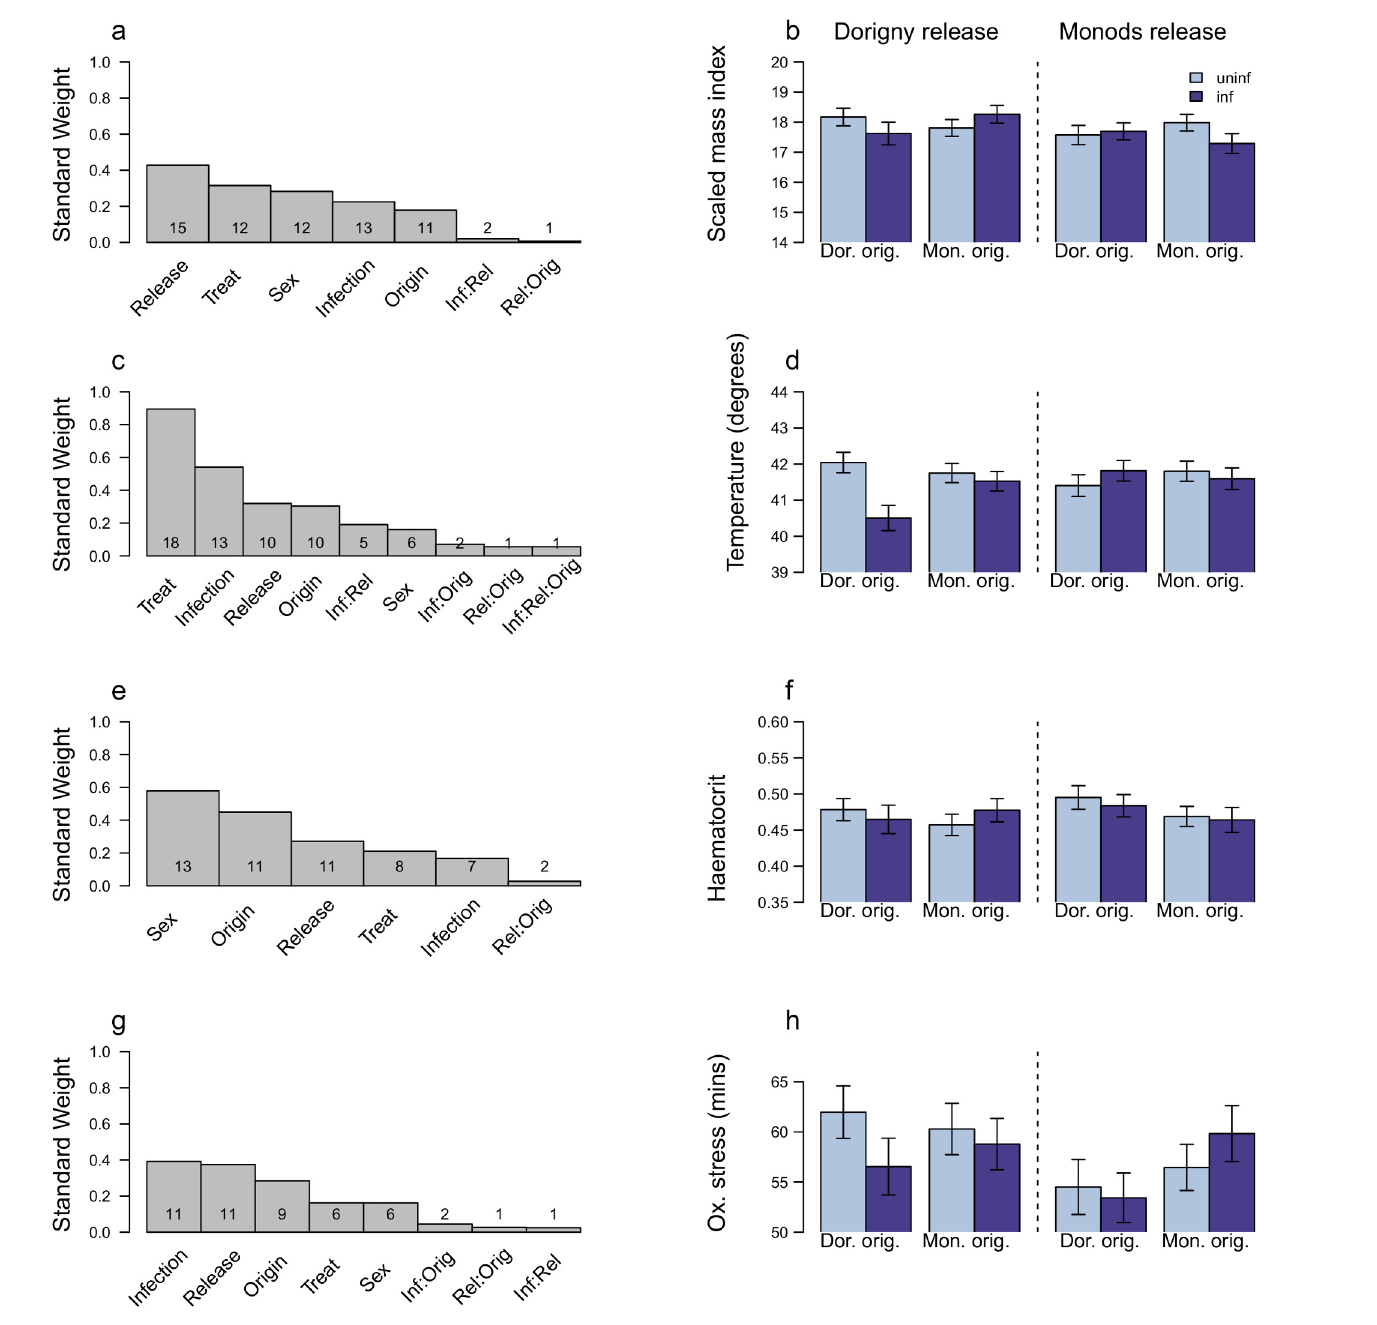
Fig 4. The factors that affect variables related to host pathology at the infection peak. a- b) SMI: standardised mass index; c- d) temperature; e- f) haematocrit; g- h) oxidative stress: membrane resistance (time taken to haemolyse half of red blood cells when faced with free radical attack). The left hand panels (a, c, e, g) show the standard weight of the predictor parameters affecting the host response variables and the number of candidate models in the 95% confidence interval model set that they occur in. Note that the interaction term indicative of host LA (Infection x Origin x Release site) is not always present. In the right hand panels (b, d, f, h) the LA effect (Infection x Origin x Release site) is explored and in these models, the LA term is explicitly retained. The predicted model averaged parameter estimates ± 1 se of each response variable is plotted on the original scale. Note that parameters that were included as covariates were set as “ fixed ” , i . e , the SW = 1, and they are therefore not shown in the plots. For full model formulae and results see tables in S1 File and S3 File. For further details of the method see Fig 1. The prediction, under a scenario of parasite adaptation, is that local birds will suffer more and have lower SMI, temperature, haematocrit and membrane